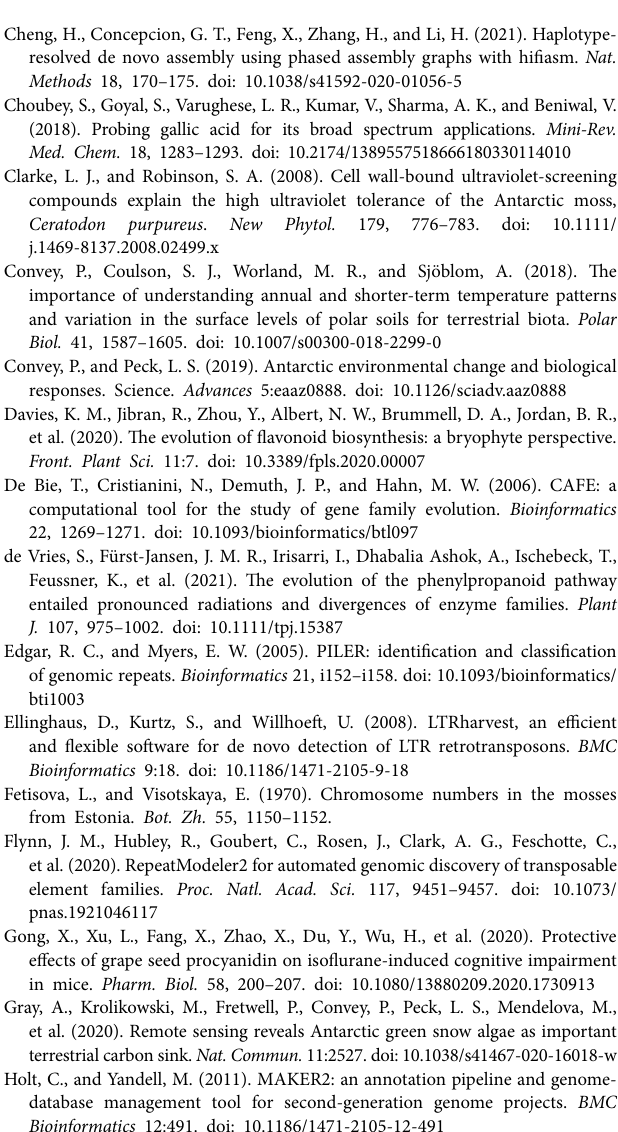
Supplementary Figure 5 | Statistical analysis of data quality and differential metabolites. (A) Principal component analysis (PCA) for mass spectrum data of UV-B radiation group and control group, and mix (quality control sample). The x axis and y axis indicate the PC1 and PC2, respectively. Three groups (i.e., CG, UV-B, and mix) were clearly separated, and three biological replicates of each group were clustered together, showing that the experiments were reproducible and reliable. (B) Heatmap shows that there were significant differences in the classes and quantities of metabolites between UV-B radiation group and control group. The green color indicates the decrease of differentially expressed metabolites, while the red color indicates the increase of differentially expressed metabolites. (C) Score scatter plot of the latent structure discriminant analysis (OPLS-DA) model for the differences between UV-B radiation group and control group. R 2 X and R 2 Y indicate the interpretation rate of X and Y matrix, respectively. Q 2 Y represents the prediction ability of the model, while a value closer to 1.0 means that the model is more stable and reliable. In addition, Q 2 Y > 0.5 can be regarded as an effective model, and Q 2 Y > 0.9 is an excellent model. The data indicated that UV-B radiation strongly changed the metabolite profiles of the Antarctic moss Pohlia nutans . (D) Statistics of significantly changed metabolites in P. nutans under UV-B